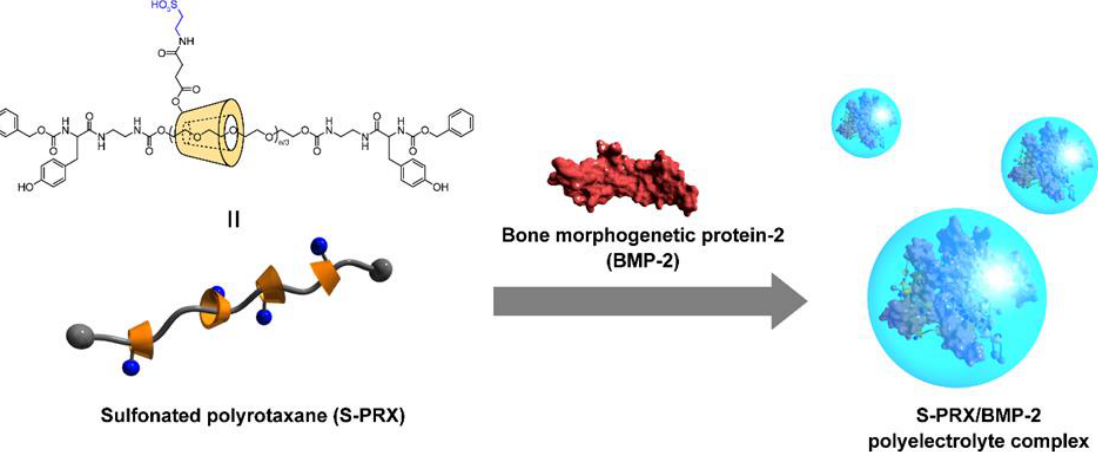
Figure 5. Chemical structure of sulfonated polyrotaxane (S-PRX), and the formation of a polyelectrolyte complex with BMP-2. Reproduced with permission from [127] © 2015 Wiley.